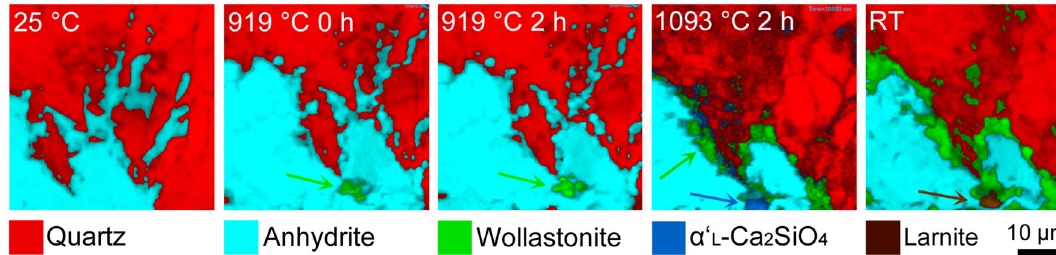
Fig. 5 Normalized false-color hyperspectral Raman images of the in situ experiment